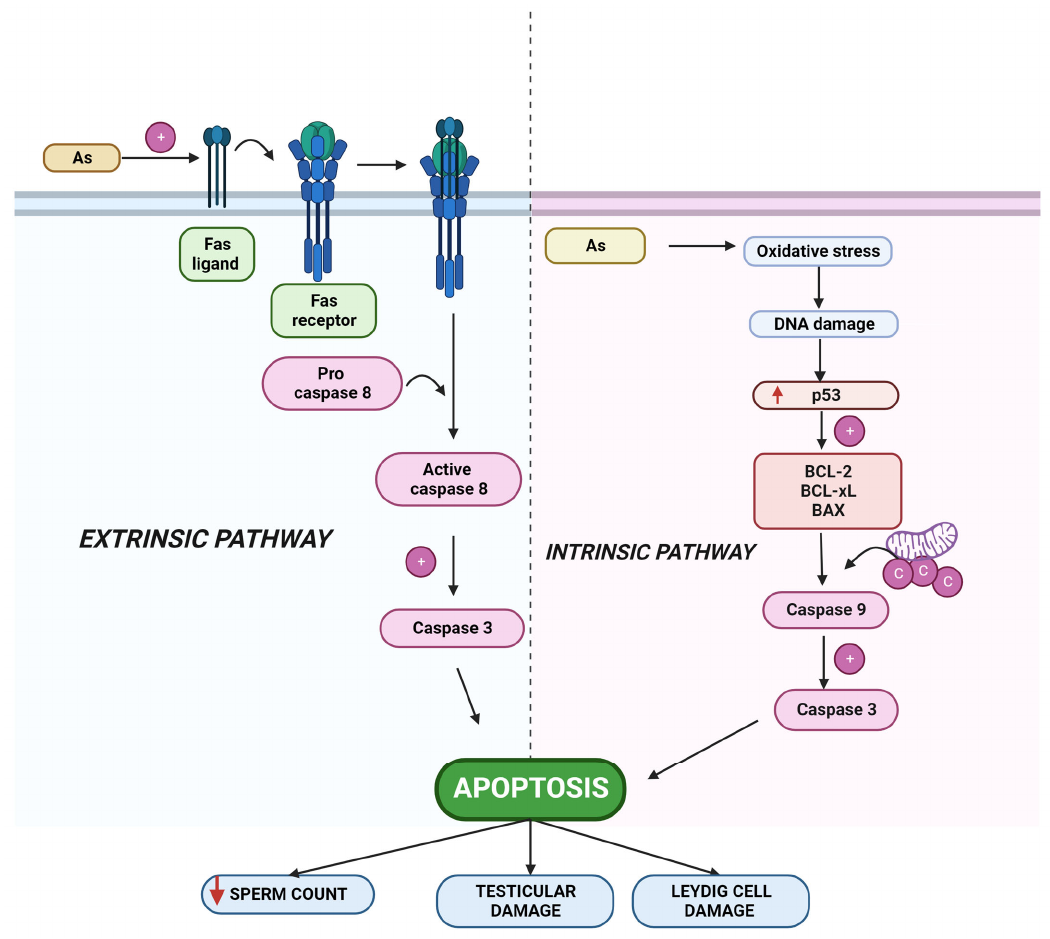
Figure 4. Diagram demonstrating how arsenic induces the intrinsic and extrinsic apoptotic path ‐ ways, which result in the death of apoptotic cells in the testes. As, arsenic, Bcl2, B ‐ cell lymphoma 2; Bcl ‐ xL, B ‐ cell lymphoma ‐ extra ‐ large; BAX, Bcl ‐ 2 ‐ associated X protein